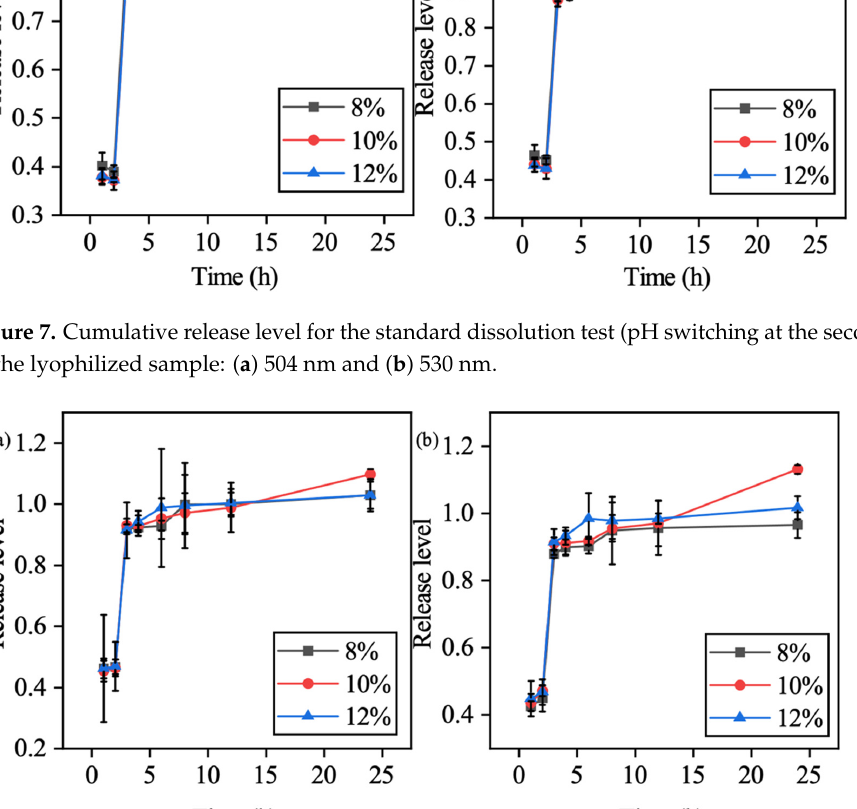
Figure 7. Cumulative release level for the standard dissolution test (pH switching at the second hour) of the lyophilized sample: ( a ) 504 nm and ( b ) 530 nm.